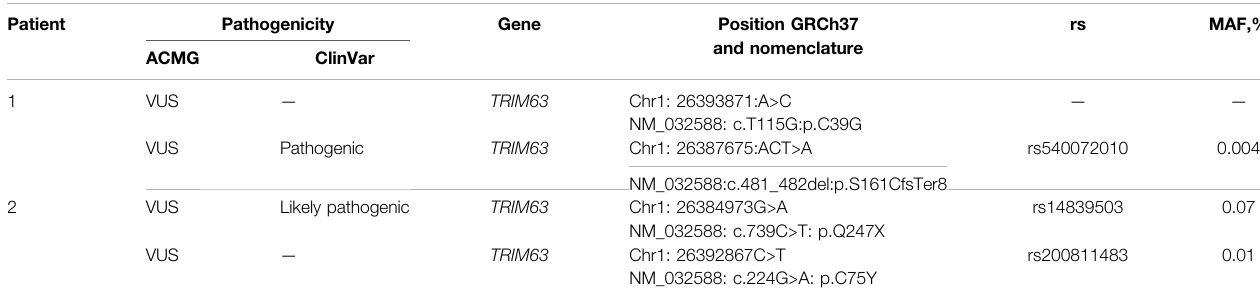
TABLE 2 | Genetic variants in TRIM63 gene of Patient 1 and Patient 2.